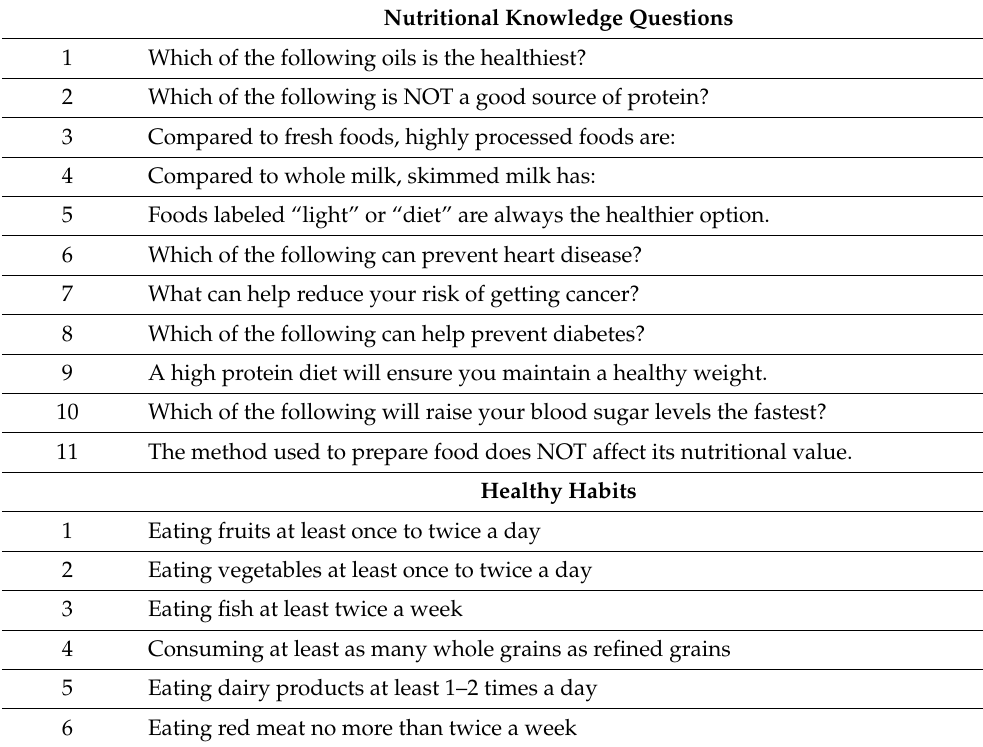
Table 1. A participant was given one point for each healthy habit he or she indicated, resulting in a maximum possible score of 6 points. Table 1. Point assignment of nutritional knowledge and healthy